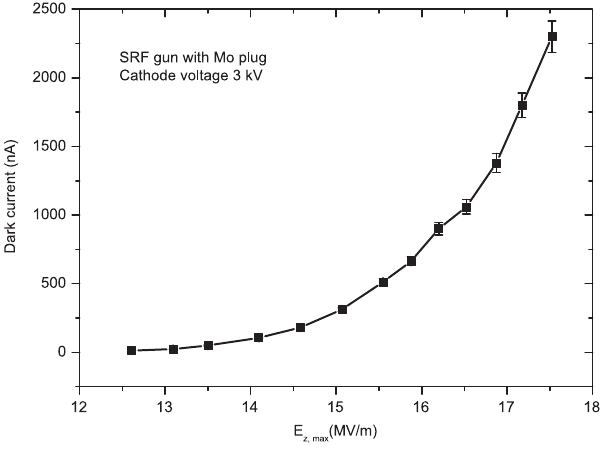
FIG. 7. Dark current vs peak field E z: for the cavity with Mo max cathode. Measurement was done with pulsed